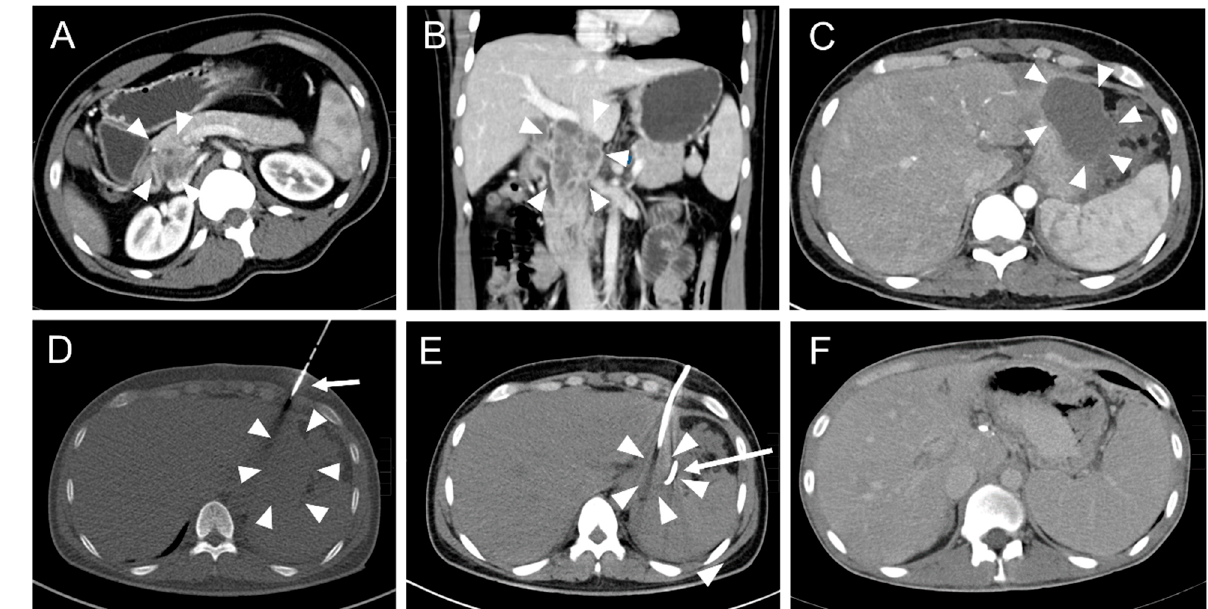
Figure 2. A typical CT fluoroscopy-guided drainage placement procedure after pancreatic surgery. ( A ) A 33-year-old male with a history of abdominal tuberculosis and the formation of an inflammatory pseudotumor in the pancreatic head (arrowheads). ( B ) Coronal reconstruction of the abdominal CT scan illustrates a multicystic mass of the pancreatic head (arrowheads) with close vascular relation to the portal vein and lower vena cava. ( C ) The patient developed subfebrile temperature and left epigastric pain 19 days after pylorus-preserving pancreaticoduodenectomy (PPPD). CT revealed a left paragastric serous fluid collection (arrowheads). ( D ) CT fluoroscopic image (10 mAs tube current). An 8F pigtail drainage was inserted into the fluid collection (arrowheads) with the trocar technique using an anterior intercosto-cartilaginary approach (arrow). ( E ) Post-interventional CT scan. Unenhanced post-drainage (arrow) CT scan showed significantly reduced paragastric fluid collection